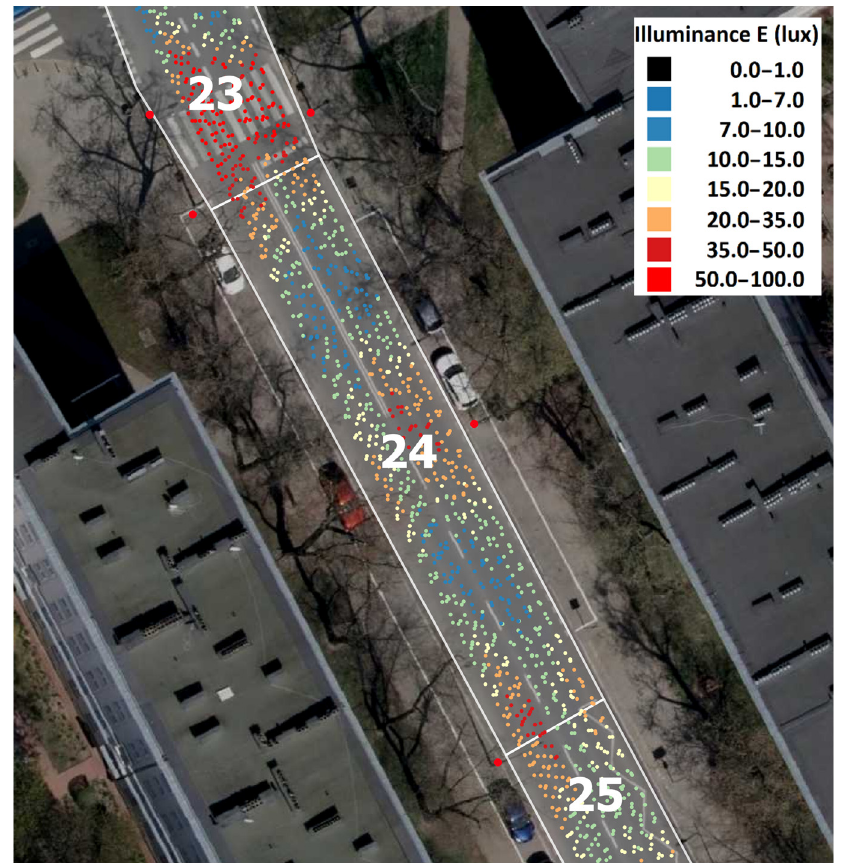
Figure 13. Example of five illuminance measurements in field No. 24.